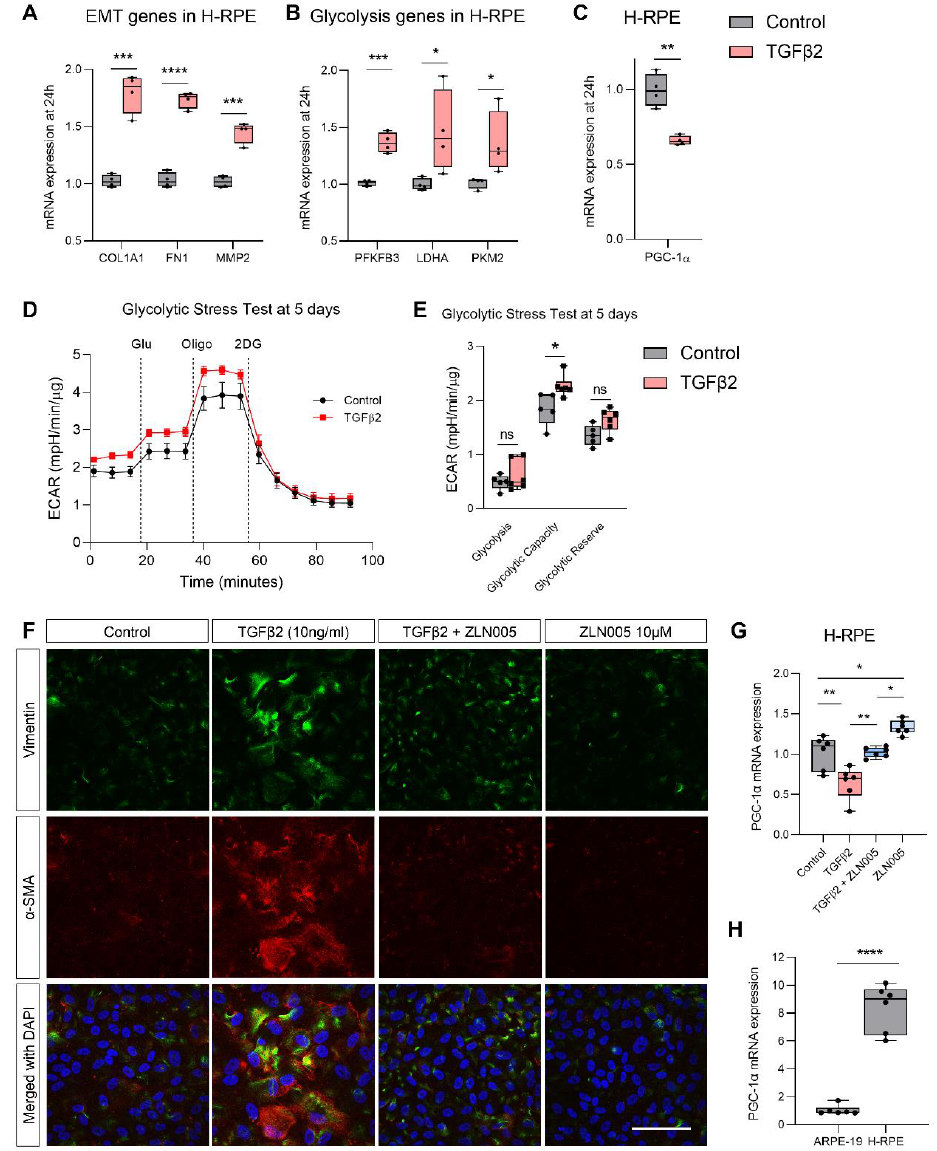
Figure 5. TGF β -induced EMT in primary human RPE is blocked by ZLN005. Quantification of mesenchymal genes ( A ) COL1A1 , FN1 , MMP2 , ( B ) glycolytic genes ( PFKFB3 , LDHA , PKM2 ) and ( C ) PGC-1 α by qPCR at 24 h with or without TGF β